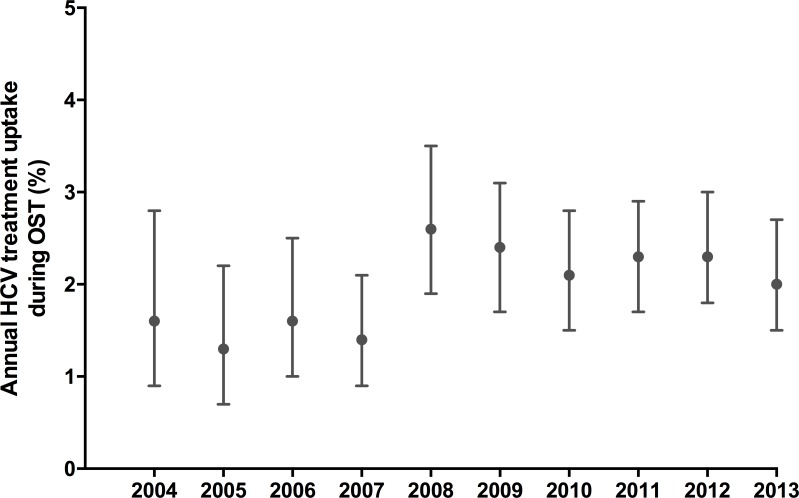
Annual hepatitis C treatment uptake during opioid substitution treatment (n = 3755).Dots indicate estimated treatment rates and bars represent 95% confidence intervals.